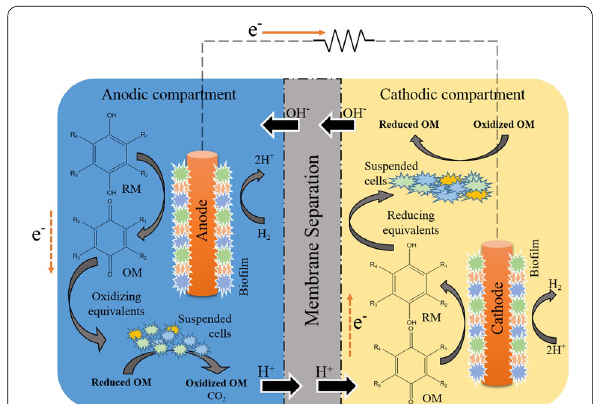
Fig. 5 Possible electron and/or “redox” transfer mechanisms taken place in microbial fuel cells (modified from Schievano et al. 2016). Fer‑ mentation systems could be in redox rebalance to have value prod‑ uct generation via different metabolic routes for energy recycling via augmentation of electron shuttles, reduction of electron transfer resistance, improvement of membrane for ion separation, and modi‑ fication of electrode materials. According to electro‑fermentation, the supply of electric current as additional reducing equivalents would create new routes of redox balancing with different reduc‑ tion potentials. In addition, H 2 /H + and redox mediators could act as electron shuttles to stimulate oxidative/reductive fermentation of suspended microbial cultures. As capabilities of ESs strongly affected by operation conditions (e.g., pH values, redox balance), appropriate manipulation of ESs and electric current would provide electrochemi‑ cally favorable environments for cellular growth and target product